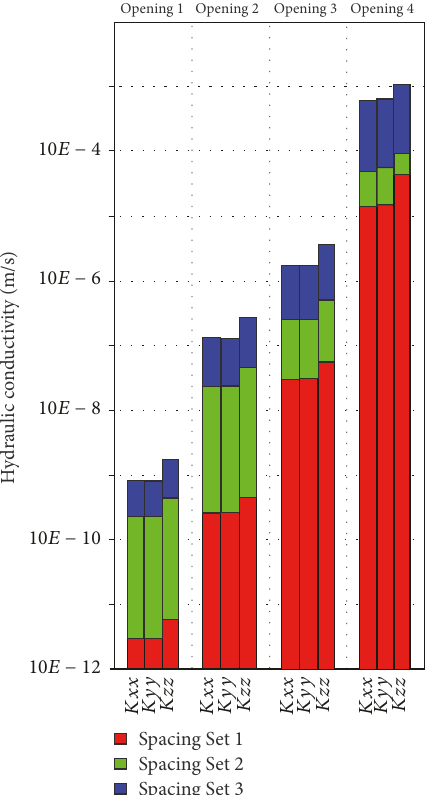
Figure 6: Hydraulic conductivity histogram achieved from the hydrostructural approach. Colours indicate the different spacing sets. Dataset is very high and hydraulic conductivity varies from 10𝐸 − 12 m/s (spacing set 1, opening set 1) to 10𝐸 − 3 m/s (spacing set 3, opening 3). Calculated value increase with the increase of the opening and the spacing. Hydrostructural approach points out a quasi-isotropic hydraulic conductivity tensor with 𝐾𝑥𝑥 and 𝐾𝑦𝑦 slightly lower than 𝐾𝑧𝑧 . An average anisotropic rate (𝐾𝑥𝑥 + 𝐾𝑦𝑦/2𝐾𝑧𝑧) can be valuated around